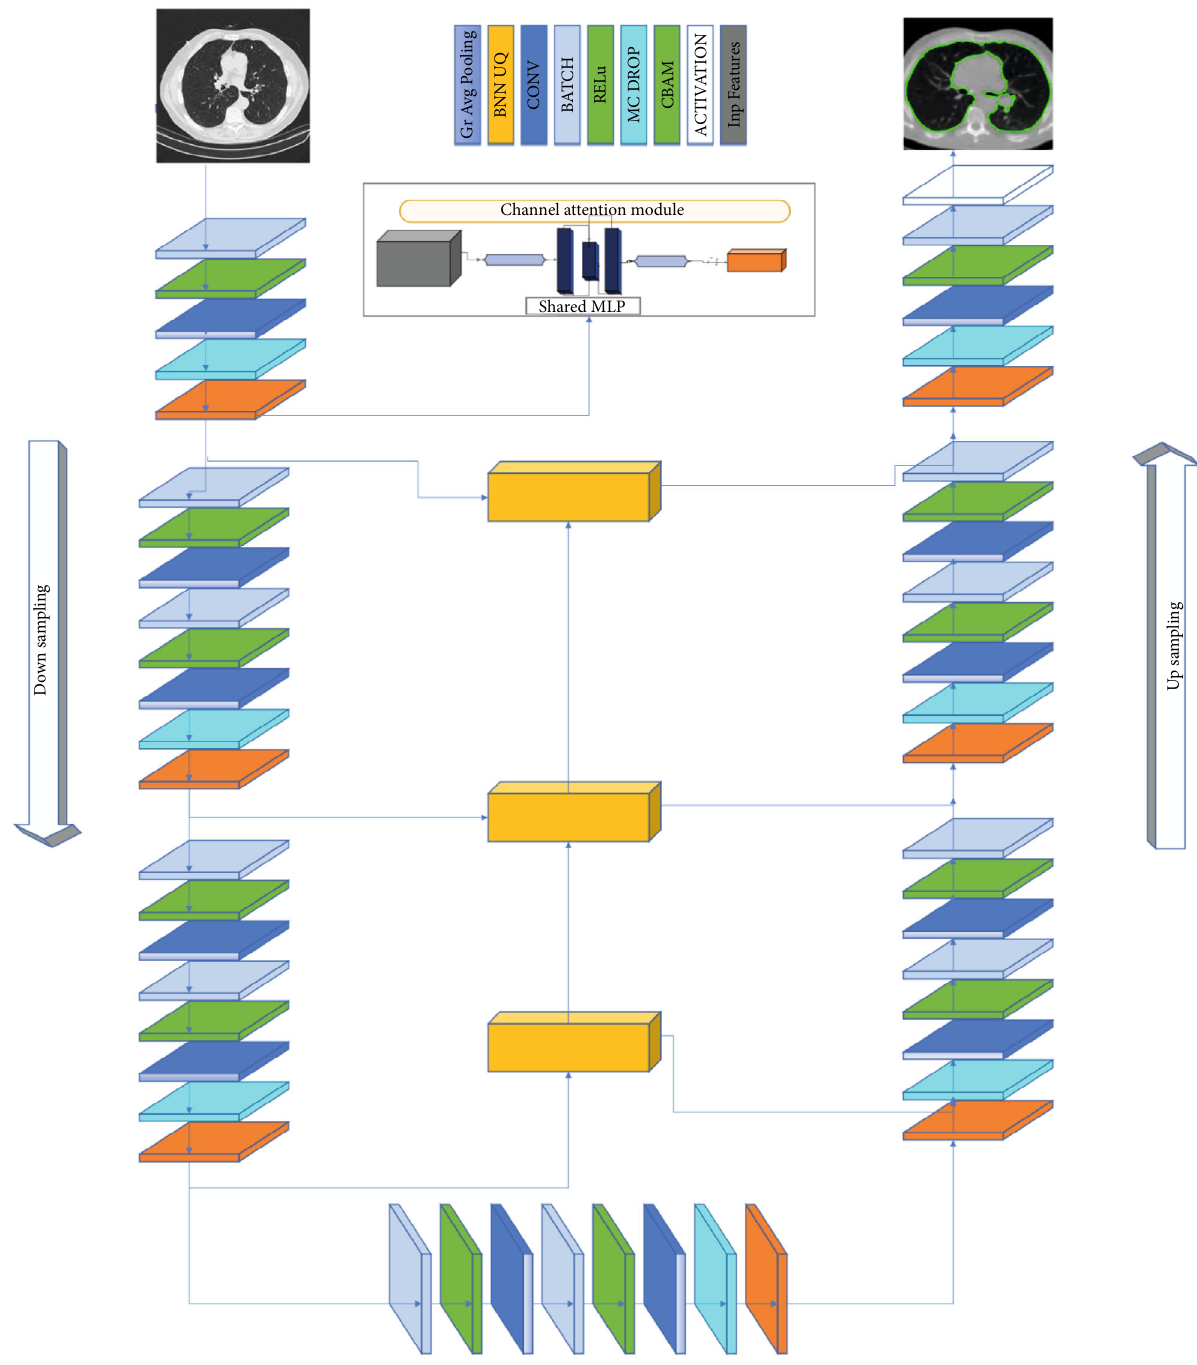
Figure 4: An encoder-stage-to-decoder stage residual connection network architecture. The encoder uses residual connections and 3D max pooling